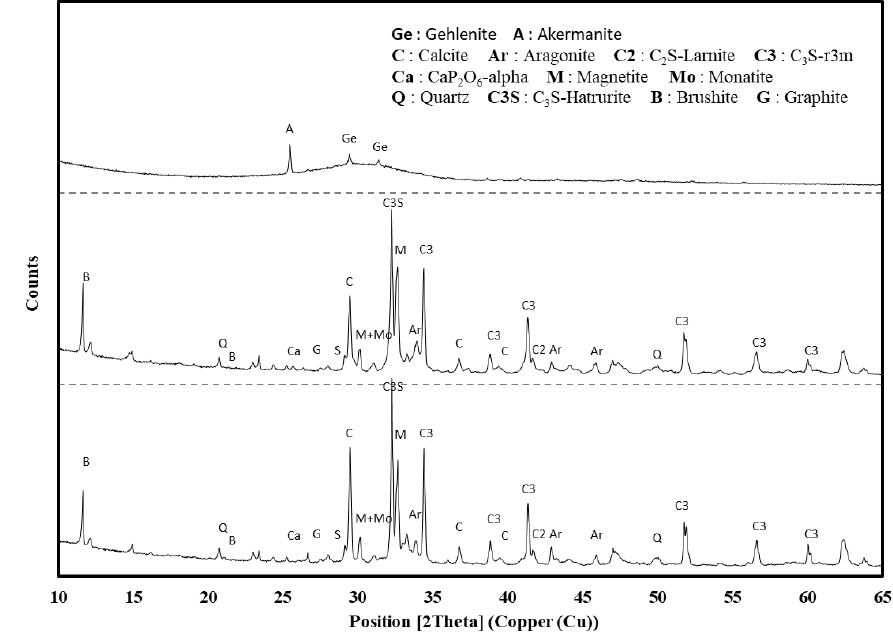
Figure 7. X-ray di ff raction patterns of GGBS, OPC, and Figure 7. X-ray diffraction patterns of GGBS, OPC, and EPC. Figure 7. X-ray diffraction patterns of GGBS, OPC, and EPC.